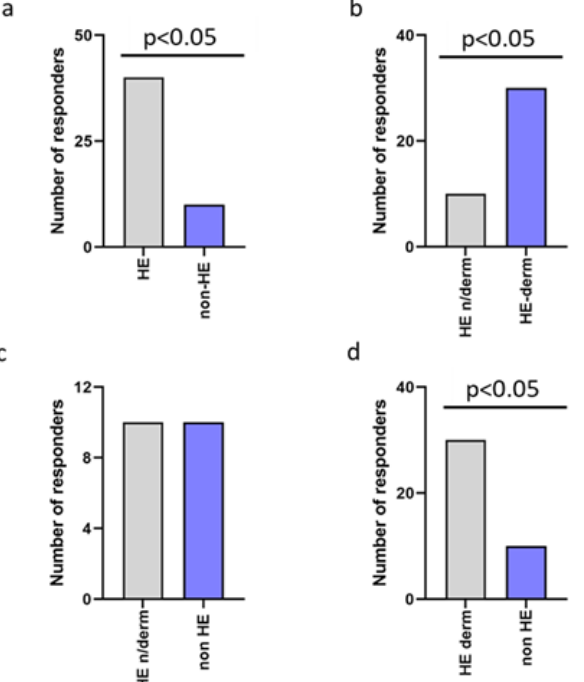
Figure 5. Comparison of the frequency of pruritis reported in the study groups: ( a ) non-HE vs. HE; ( b ) HE-n/derm vs. HE-derm; ( c ) non-HE vs. HE-n/derm; ( d ) non-HE vs. HE-derm.